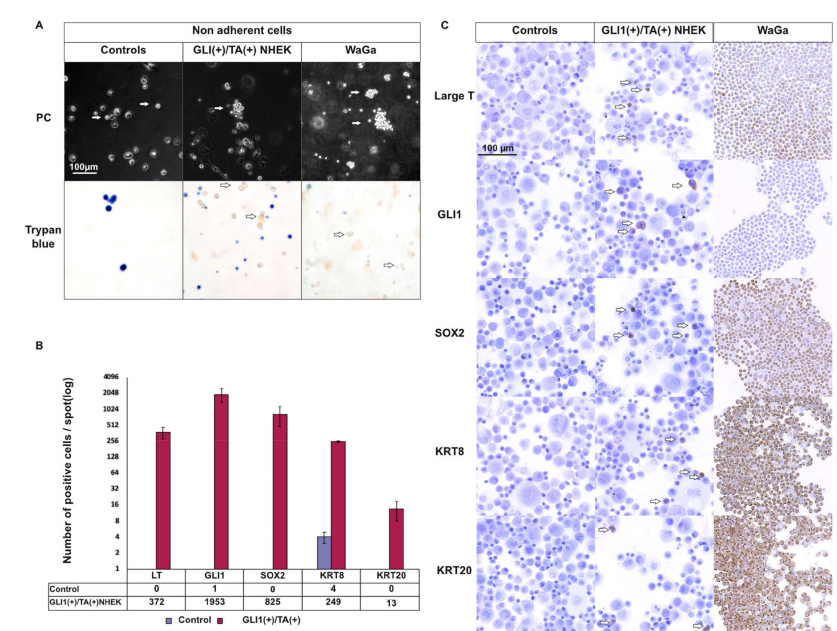
Figure 4. Induction of late MC markers by combined expression of GLI1 and Merkel cell